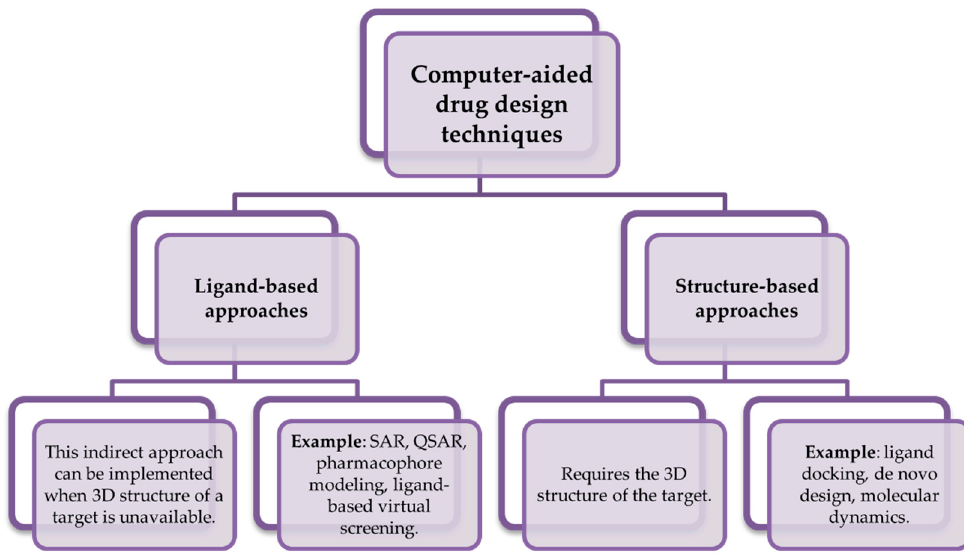
Figure 1. Classification of computer-aided drug design techniques (CADD) and the most commonly used methods. SAR—Structure-activity relationship; QSAR—Quantitative structure-activity relationship.